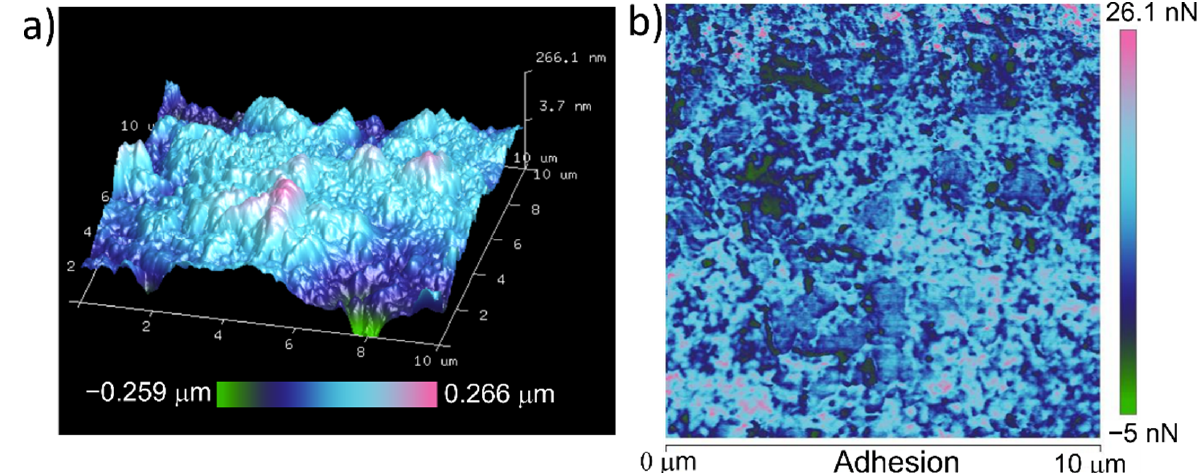
Figure 15. ( a ) Example of 3D topography on a 10 × 10 µm surface obtained on Obourg chalk. ( b ) Example of adhesion force map on a 10 × 10 µm surface for Obourg chalk.